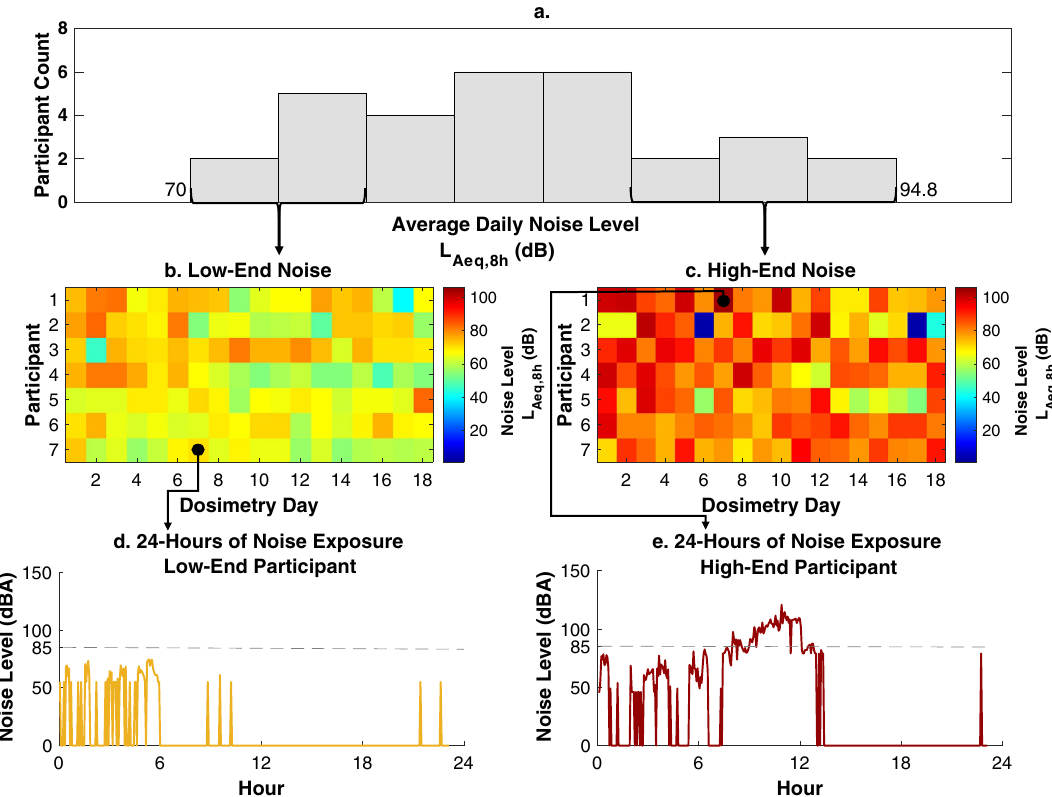
Figure 3. Noise exposure profiles. ( a ) A histogram of average daily noise levels across the dataset (70–94.80 L Aeq, 8 h (dB)). Average daily noise levels (dB) were derived by averaging daily exposure across three weeks of measurement. For illustrative purposes, dB levels for individual measurement days are plotted for the participants in the lower and upper tiers of the histogram plot. Below this histogram, image plots show daily noise levels for the seven participants with the lowest noise levels ( b ) and the seven participants with the highest noise levels ( c ). For each participant, sound levels are shown for the 18-days for which 24-h long recordings were made (partial days are omitted from the image). To highlight the granularity of the data that went into calculating noise levels for each day, a sample 24-h time period is plotted for two participants, one with the lowest average daily noise dose ( d ) and one with the highest average daily noise dose ( e ). For consistency, each plot highlights noise levels measured on the Thursday during Round 2, the second measurement week, for both participants. The dotted gray line at 85 (dBA) represents the recommended exposure limit.